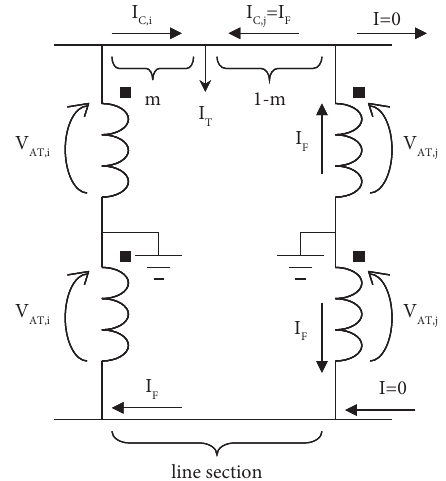
Figure 6: Sketch to illustrate the deduction for